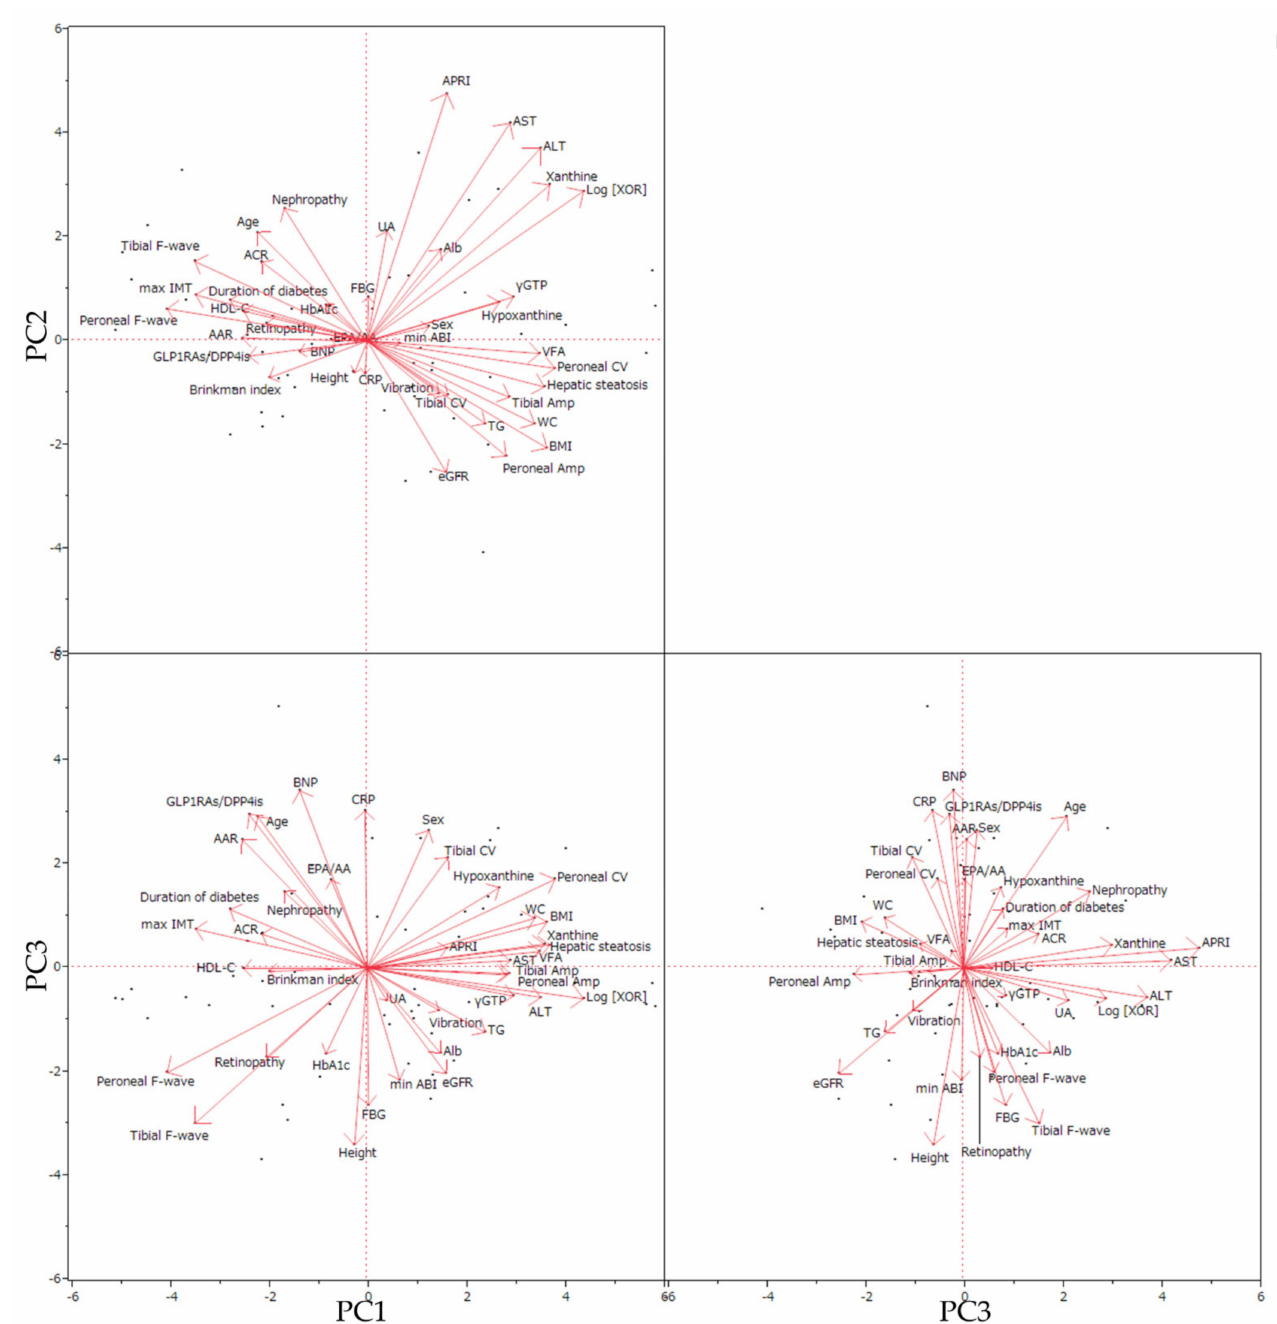
Figure 4. Visualization of correlations between variabilities in PCA biplots. PC, principal component; Amp, amplitude; CV, conduction velocity; WC, waist